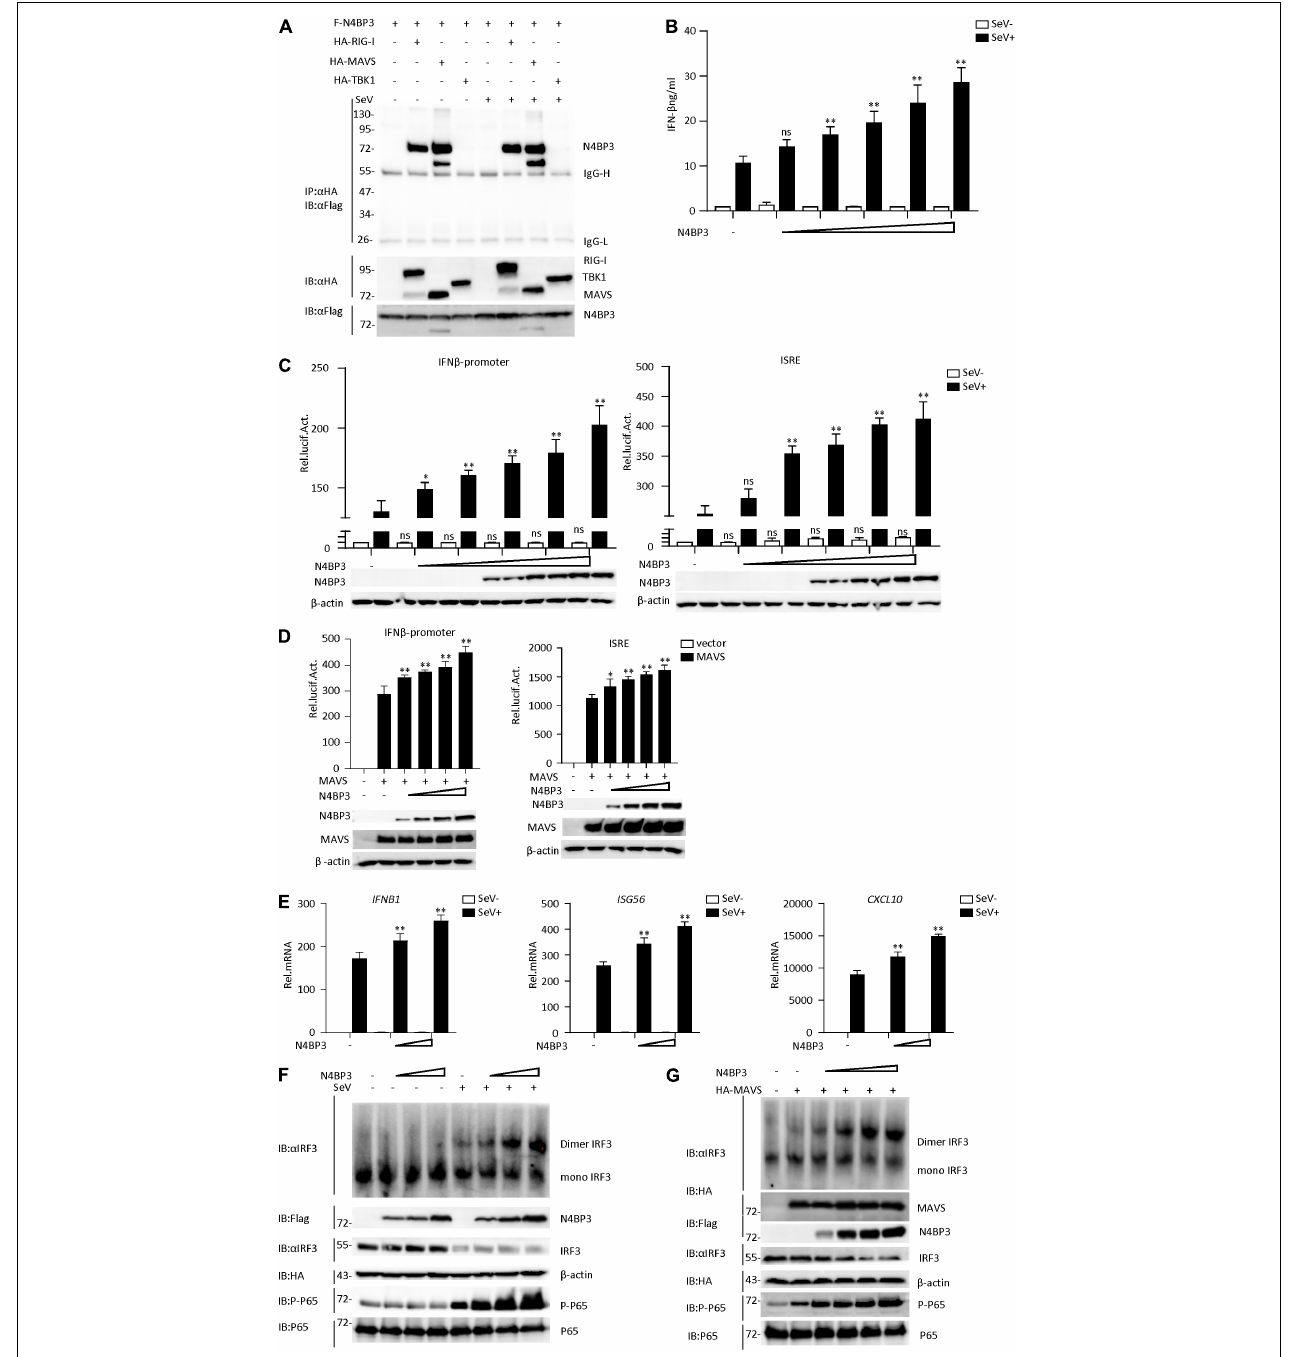
FIGURE 1 | N4BP3 is a positive regulator of the RIG-I-MAVS antiviral signal pathway. (A) N4BP3 interacts with RIG-I and MAVS. 293T were transfected with the indicated plasmid (3 µ g each). 24 h after transfection, cells were left uninfected or infected with SeV before harvested and lysed to perform Co-immunoprecipitation assays with anti-HA, following immunoblotting assay with anti-Flag. Expression levels of the proteins were analyzed by immunoblot analysis of the lysates with anti-HA and anti-Flag antibodies. (B) N4BP3 promotes the production of IFN- β . Transfect different doses (0, 0.01, 0.1, 0.5, 1.0, and 1.5 µ g) of N4BP3 expression plasmid into 24-well plates. After 12 h of transfection, the cells were left uninfected or infected with SeV for 12 h, and the concentration of the cytokines in the culture supernatant was measured by ELISA. The data table shown were presented as mean ± SD, n = 3, * P < 0.05, ** P < 0.01. (C) N4BP3 promotes the activation of the IFN- β promoter and ISRE induced by SeV. The IFN- β promoter or ISRE luciferase plasmid (0.05 µ g) was transfected into 293T cells ( ∼ 1 × 10 5 ) cultured in a 24-well plate, and different doses (0, 0.01, 0.1, 0.5, 1.0, and 1.5 µ g each) of N4BP3 expression plasmids were transfected simultaneously. After 12 h of transfection, cells were left uninfected or infected with SeV for 12 h, and the dual-luciferase reporter gene experiment was performed. The data table shown were presented as